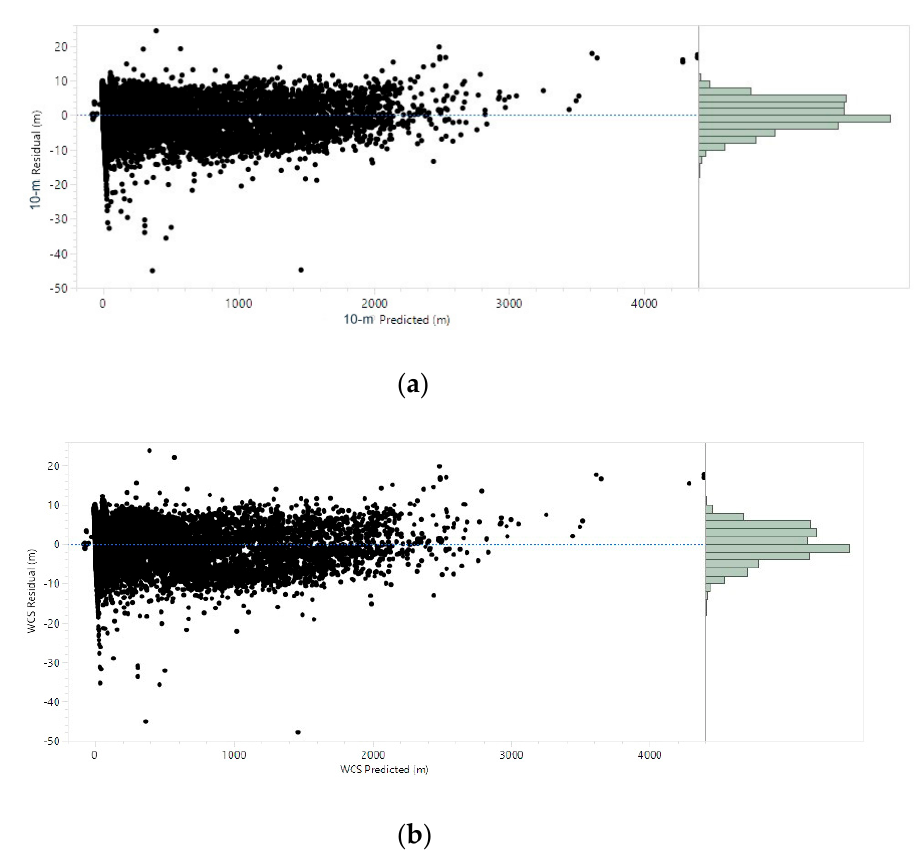
Figure 7. ( a ). Residual distributions of 1/3 arc-second DEM vs. OPUS Points. ( b ). Residual distributions of 3DEP Web Coverage Service (WCS) vs. OPUS Points.